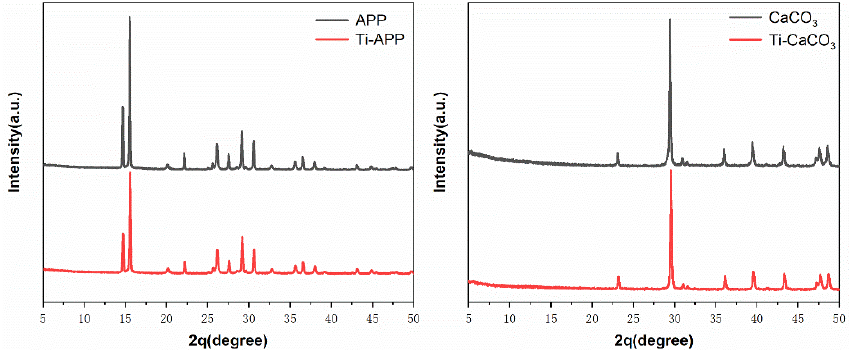
Figure 6. FTIR spectra of APP, CaCO 3 and their modification.